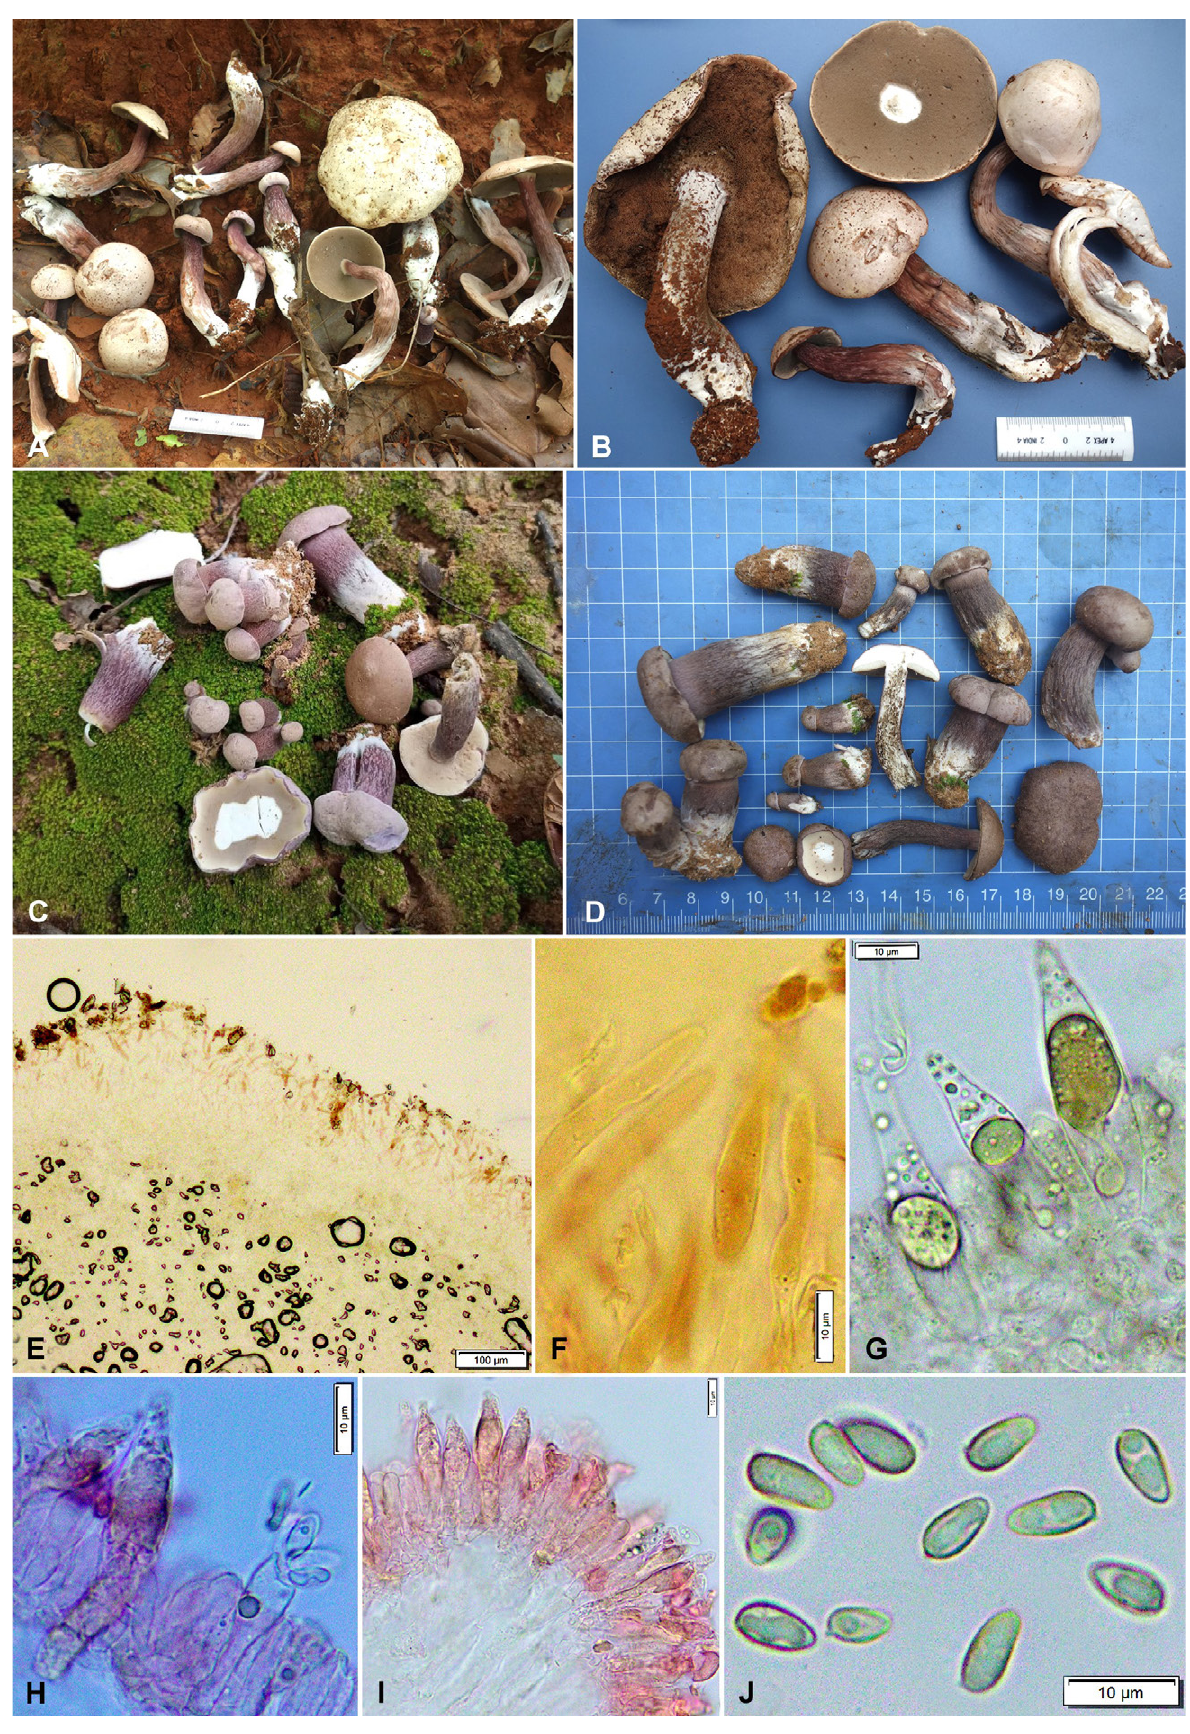
Figure 3. Tylopilus glutinosus . A–D. Fresh basidiomata in the field and basecamp. E. Cross section through pileipellis. F. Terminal cells of the pileipellis. G. Caulocystidia. H. Pleurocystidia and basidia. I. Tube edge showing cheilocystidia. J. Basidiospores. Scale bars: E = 100 µm; F–J = 10